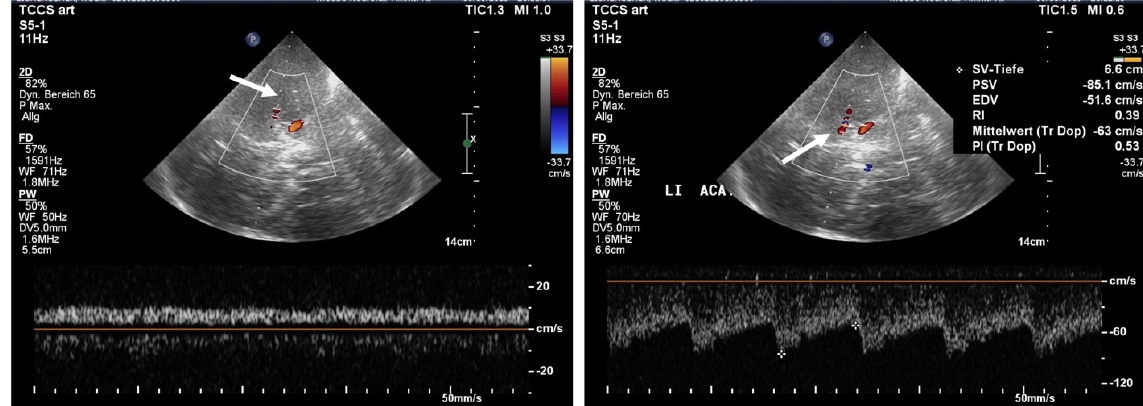
Figure 5. TCCS scan through the left temporal bone window with transcranial color-coded sonography in the upper and Doppler spectrum from the Doppler gate. Left : Doppler gate placed at the origin of the middle cerebral artery with absent color filling (arrow) in the M1 segment and pseudo-venous flow at the beginning of the M1-Segment (Doppler gate depth 55 mm). Right : anterior cerebral artery color-coded in red due to aliasing due to increased flow velocities with the Doppler gate placed at a depth of 66 mm in the A1-segment showing increased flow of 63 cm/s mean maximum flow and decreased resistance index of 0.39 all suggestive of collateral